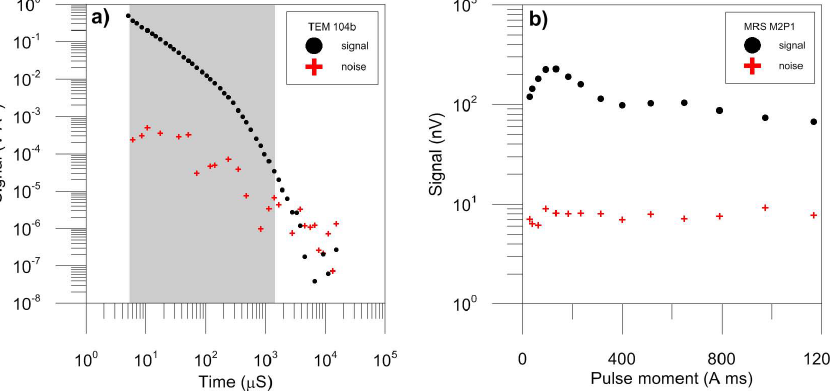
Fig. 2. Example of geophysical field measurments. (a) TEM measurements: the grey zone is the time window used for the synthetic mod- elling. (b) MRS